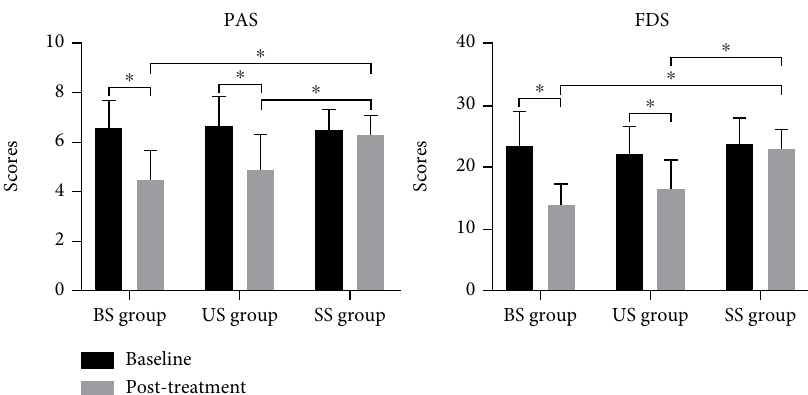
Figure 6: Changes in clinical swallowing function in patients after repeated transcranial magnetic stimulation. BS group: bilateral stimulation group; US group: unilateral stimulation group; SS group: sham stimulation group; PAS: penetration aspiration scale; FDS: functional dysphagia scale. ∗ P < 0 : 05 .